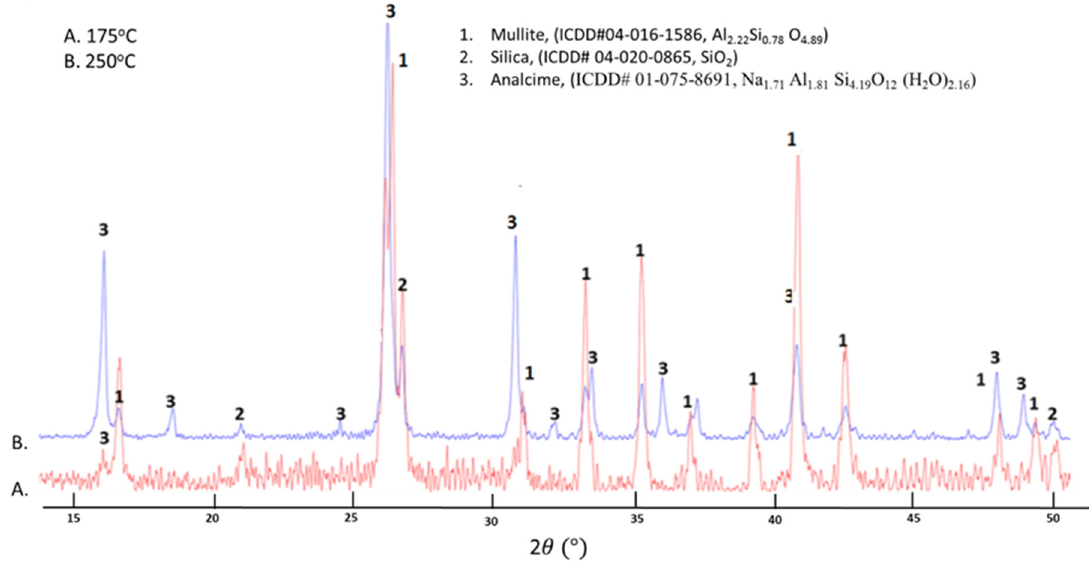
◦ C- and 250 ◦ C-autoclaved PMHS/FCS/SMS Figure 11. XRD patterns for 175°- and 250 °C-autoclaved PMHS/FCS/SMS blend. Figure 11. XRD patterns for 175